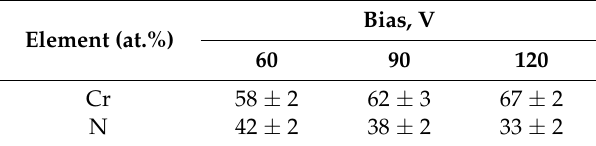
Table 1. WDS measurements obtained for CrN x coatings at various substrate bias.